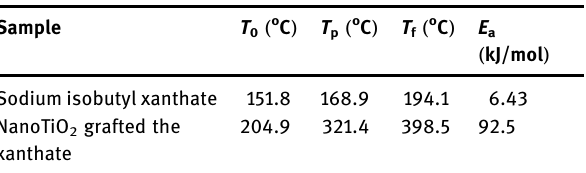
Table 2: The characteristic parameters ( initial temperature ( T 0 ) , fi nal temperature ( T ) , temperature at maximum decomposition rate f ( T ) , and E ) of thermal degradation of sodium isobutyl xanthate p a and